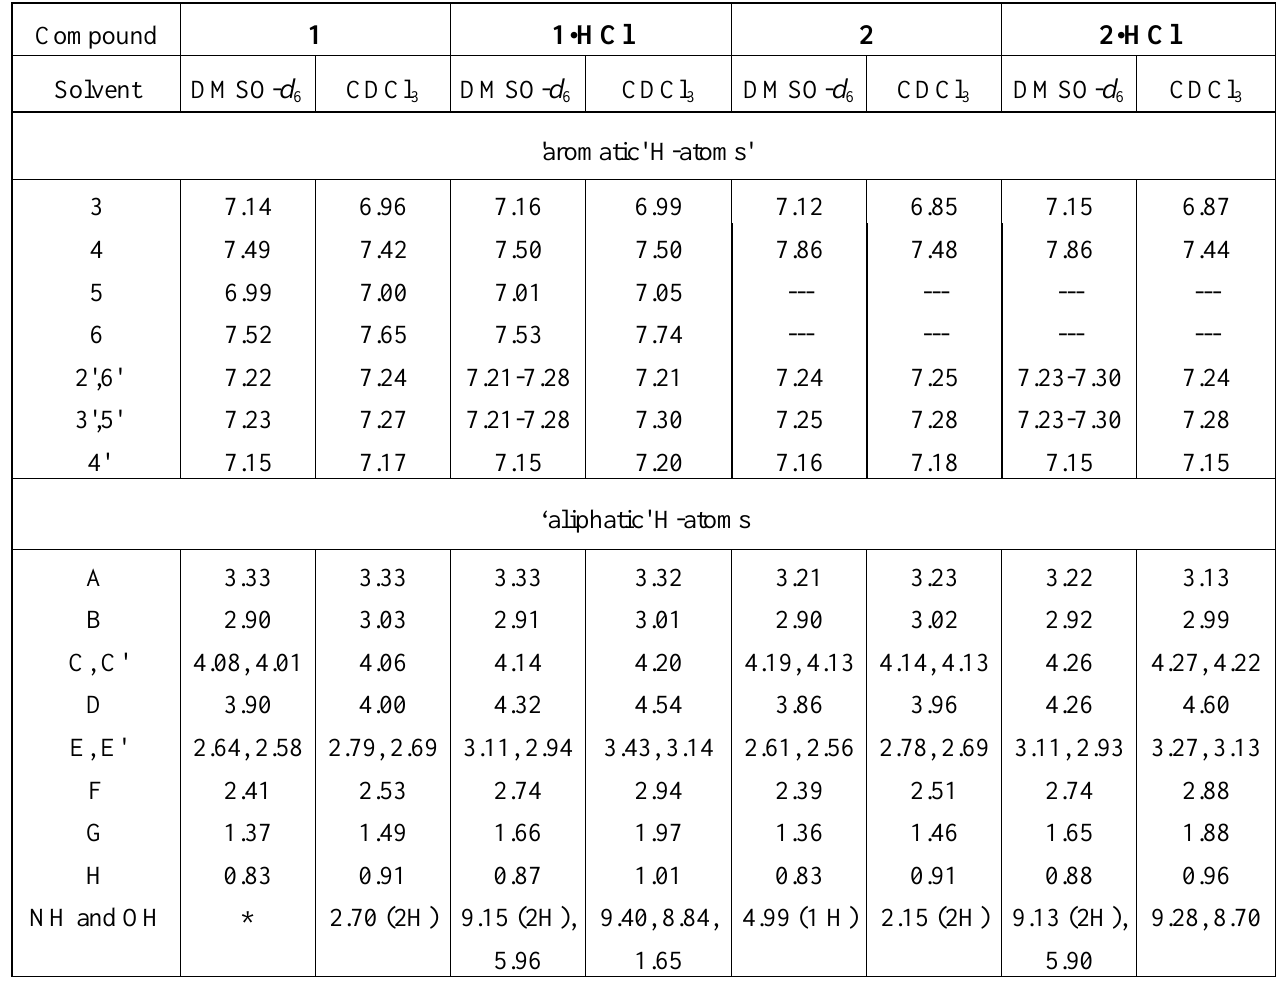
Table 1 : 1 H- Chemical Shifts and Selected 1 H, 1 H-Coupling